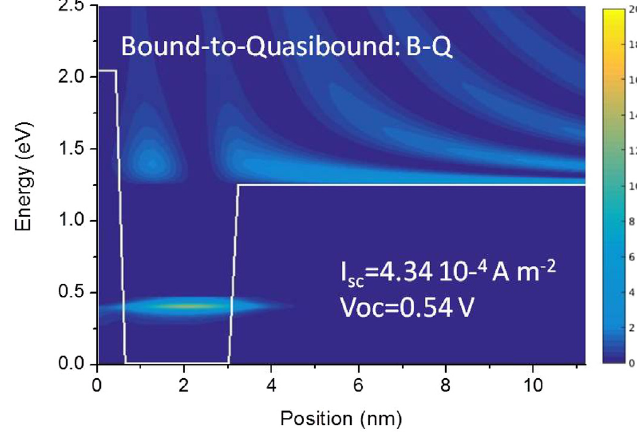
Fig. 4. The band-diagram (white line) and the local DOS of electrons in the